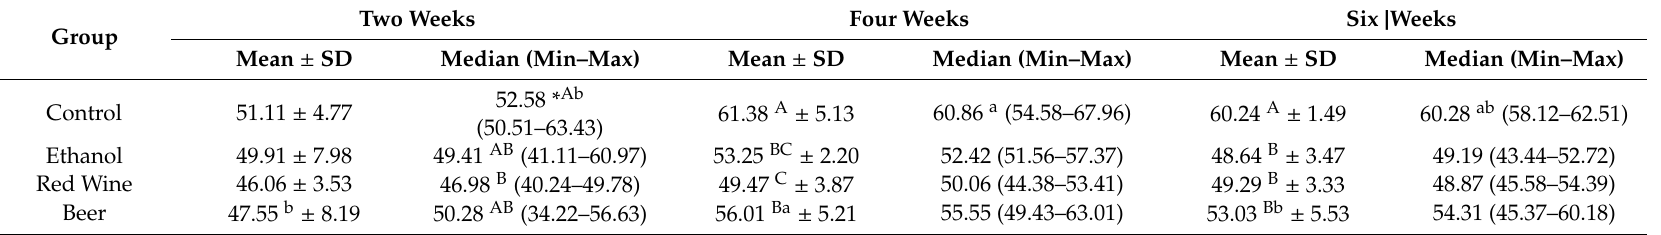
Table 3. Daily diet intake (kcal / day) in the groups of experimental rats stratified by a group and experiment duration.